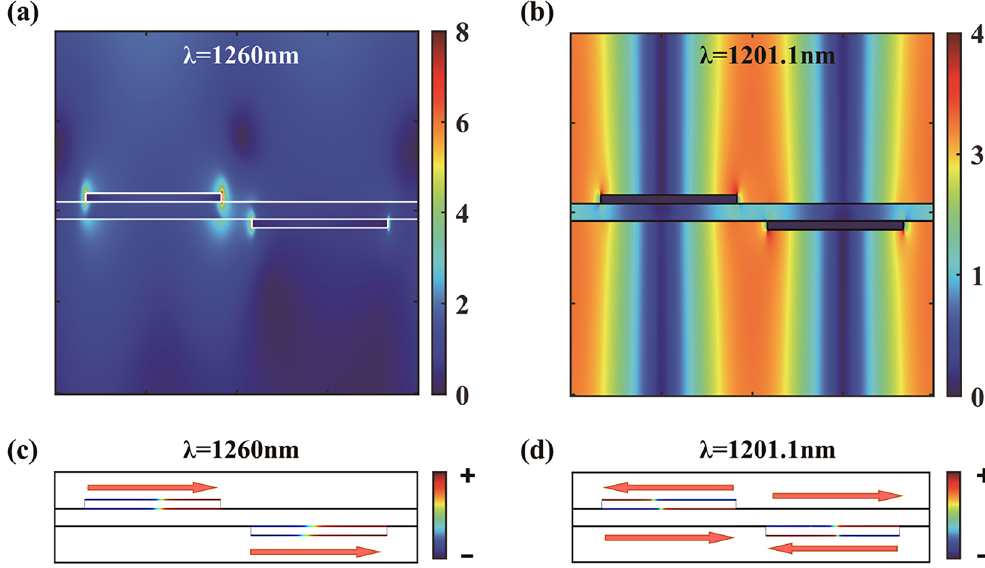
Figure 2. Calculated spatial distribution of magnitude of the electric field and corresponding charge distribution for two different wavelengths. ( a ) The electric field and ( c ) the charge for a somewhat longer wavelength of λ = 1260 nm where the reflection has a maximum corresponding to super-radiant mode. ( b ) The electric field and ( d ) the charge at the transmission peak of λ = 1201.1 nm corresponding to sub-radiative mode. The solid lines in panels ( a ) and ( b ) indicate the interfaces of